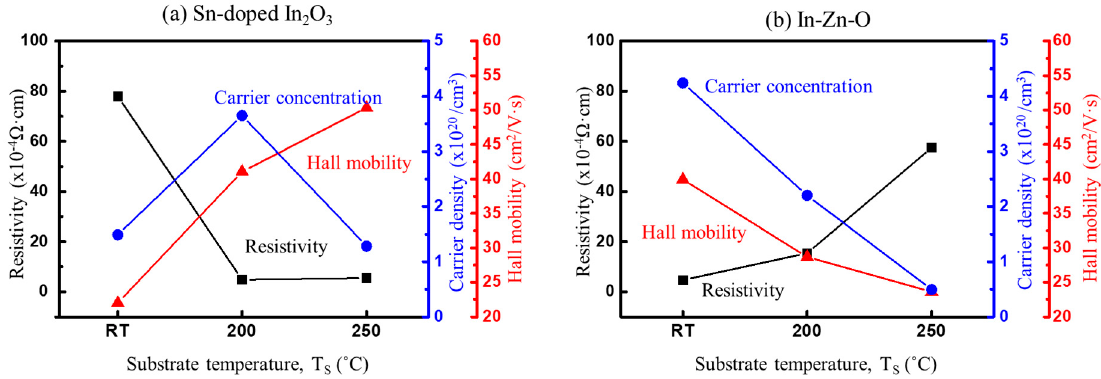
Figure 6. Resistivity ( ■ ), carrier concentration ( ● ), and Hall mobility ( ▲ ) of the ( a ) ITO and ( b ) IZO films deposited at various substrate temperatures ( T S : RT, 200, and 250 °C).